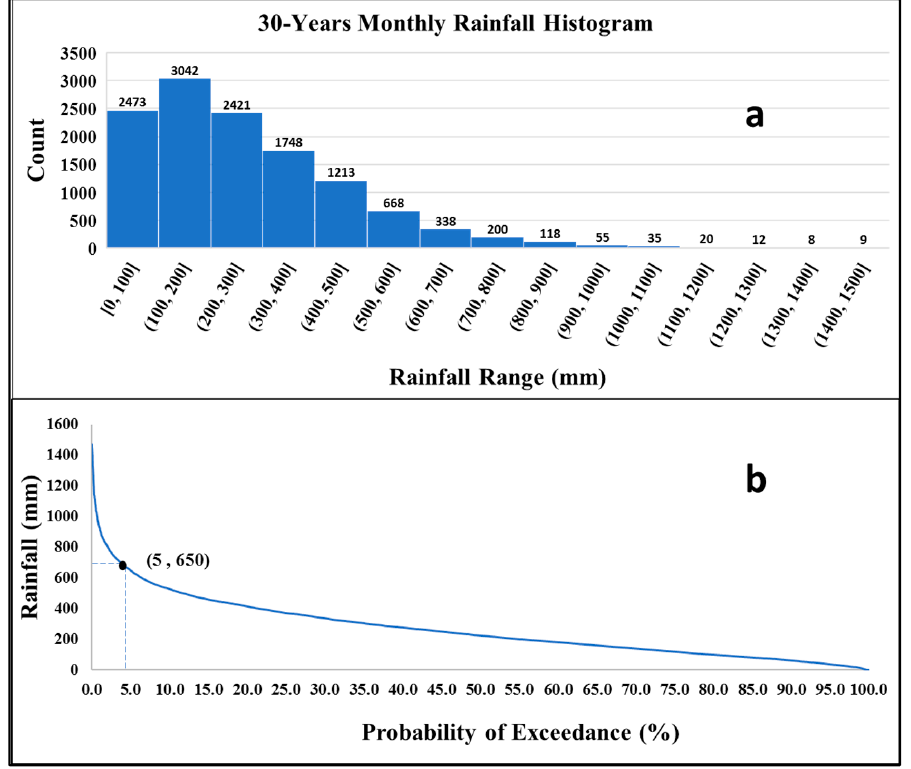
Figure 6. ( a ) The histogram and ( b ) the probability of exceedance curve of the monthly rainfall (June to September) obtained for the years 1990–2019.